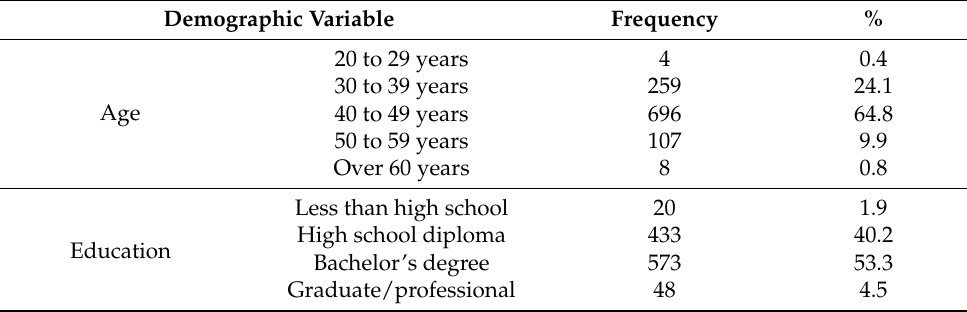
Table 1. Demographic information of the sample ( N =